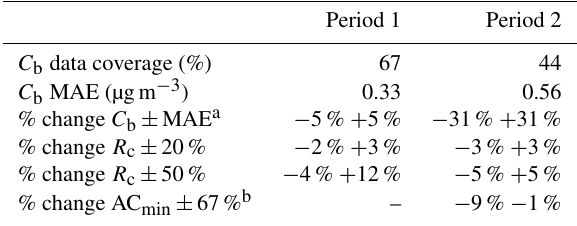
Table 4. Sensitivity analysis of the percentage change of the bLS-R gross emission estimates ( Q dep ) to variation in predicted C b and R c as well as the source area coefficient parameter AC min